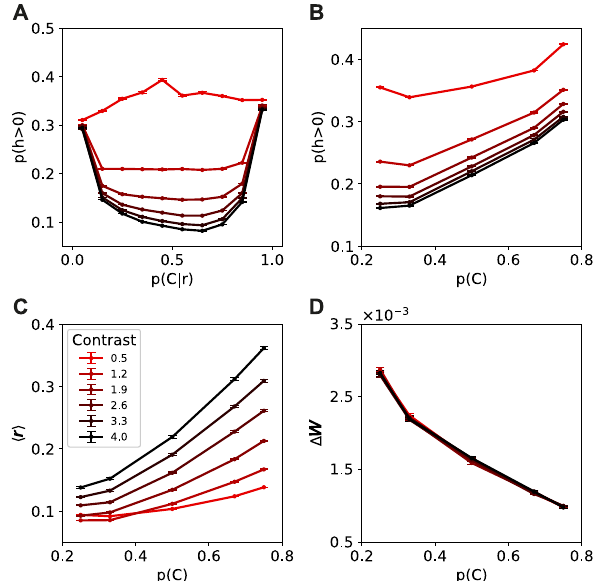
Figure 4. Neural activity changes due to input and prior uncertainty. (A) Number of neurons with non-zero activity in response to both stimuli from class 1 and class 2. Fewer neurons in the hidden layer responded when the input contrast was higher. On the other hand, more neurons responded when the posterior was certain which class was presented. (B) Number of neurons with non-zero activity in response to stimuli from class 1. While fewer neurons responded to higher contrast stimuli, more neurons were active when the prior probability of the presented stimulus class was higher. (C) The average activity of the population, in response to stimuli from class 1, increased both with stimulus contrast and prior probability. (D) The weights in the network require less adaptation in response to likely stimuli, while the contrast has no influence on the strength of the weight